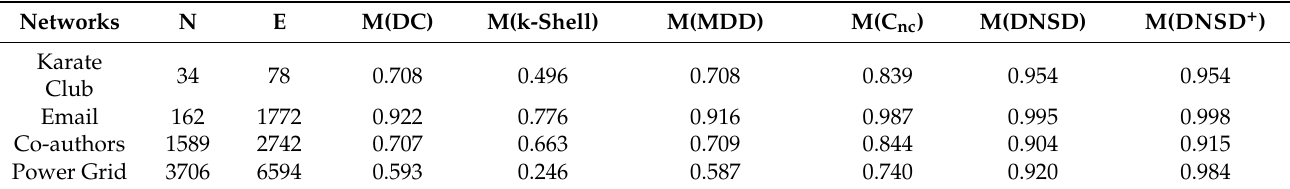
Table 2. The Monotonicity of ranking lists generated by different methods. N is the number of nodes and E is the number of edges in the network. M(DC) represents the monotonicity of ranking obtained by Degree Centrality method and others have the similar meaning.